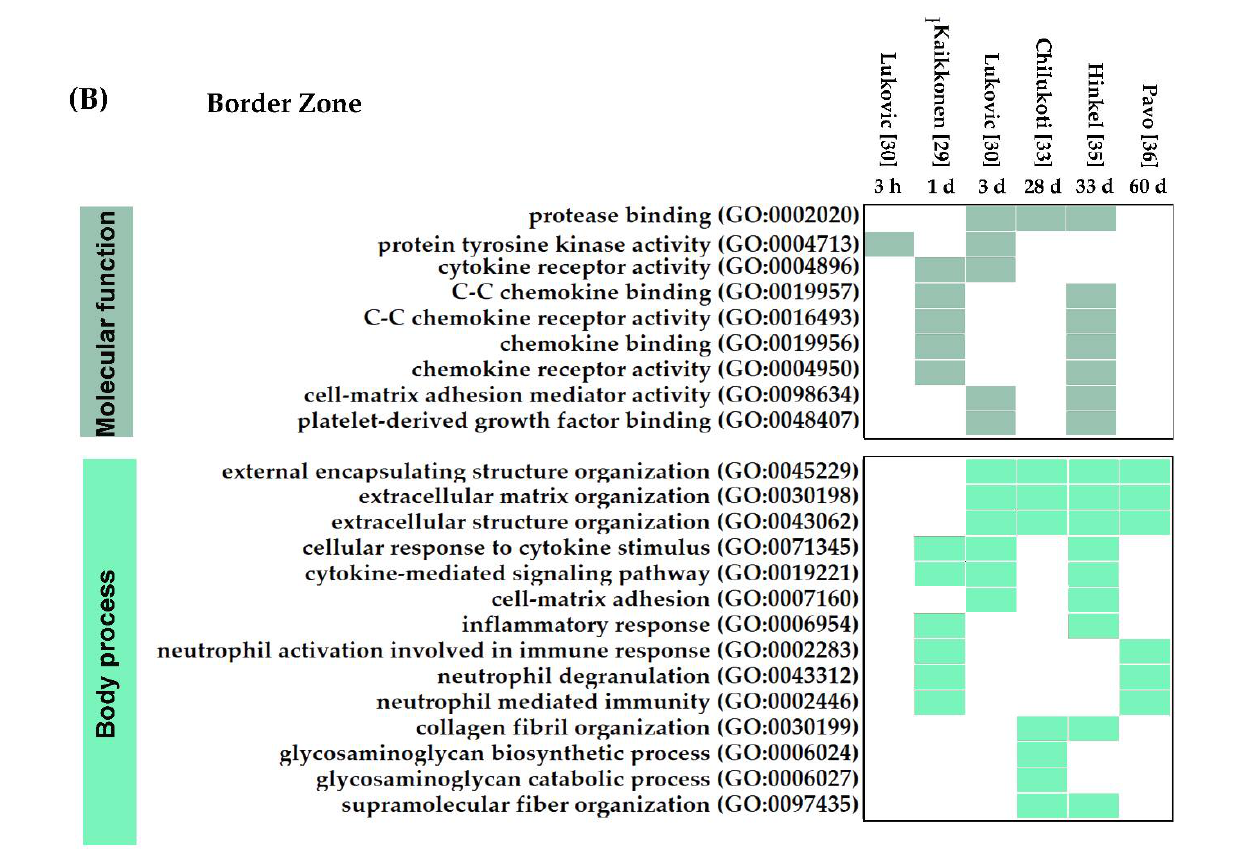
Figure 4. Active molecular functions and body processes in the Infarct Core ( A ) and the Border Zone ( B ). For each histological area, upregulated genes registered in the published data sets were analyzed separately using Enrichr and g: Profiler to identify active MFs and BPs in each study. Only results with significant adjusted p -values (<0.05) were considered as active in the tissues corresponding to each data set. Identified active MFs and BPs in at least two data sets were defined as active in this comprehensive IRI analysis. Functions and Processes were ordered chronologically. Colored boxes indicate the active Functions and